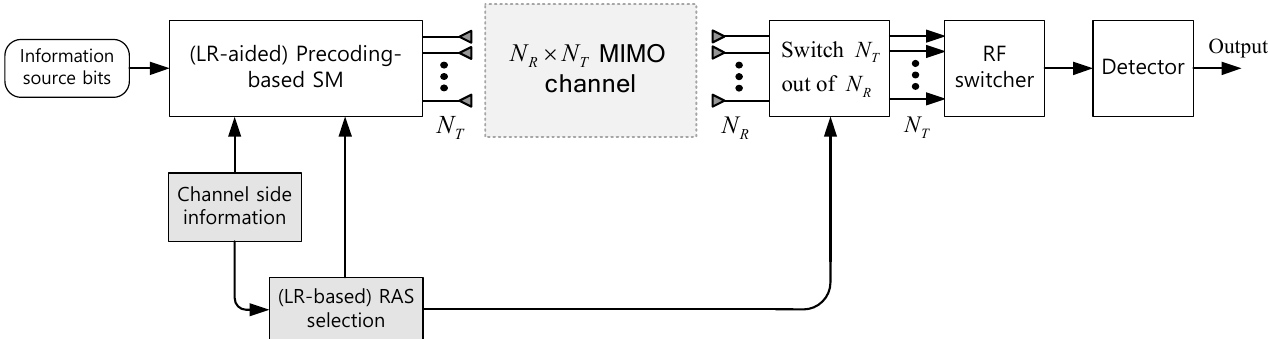
Figure 1. Block diagram of an (LR-aided) PSM MIMO TDD system with (LR-based) RAS